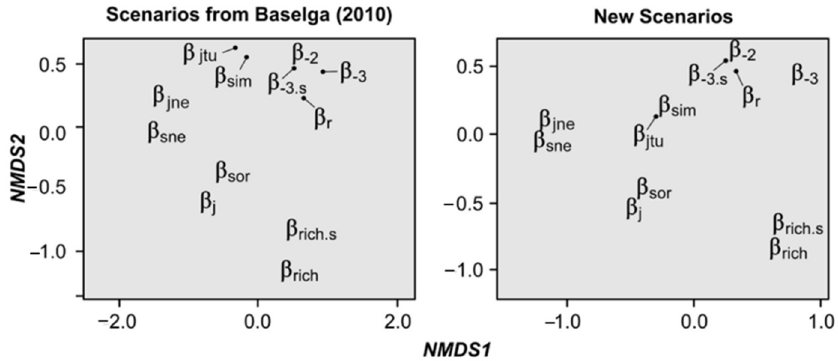
Figure 3. Non-metric multidimensional scaling (NMDS) analyses showing the similarities/dissimilarities of the results of the 12 assessed measures with both sets of scenarios (see Figure S1). Arrows indicate the true location of indices, which were moved for graphical purposes.